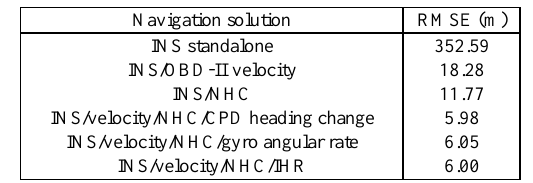
Figure 22. INS/different updates trajectory for 90 seconds